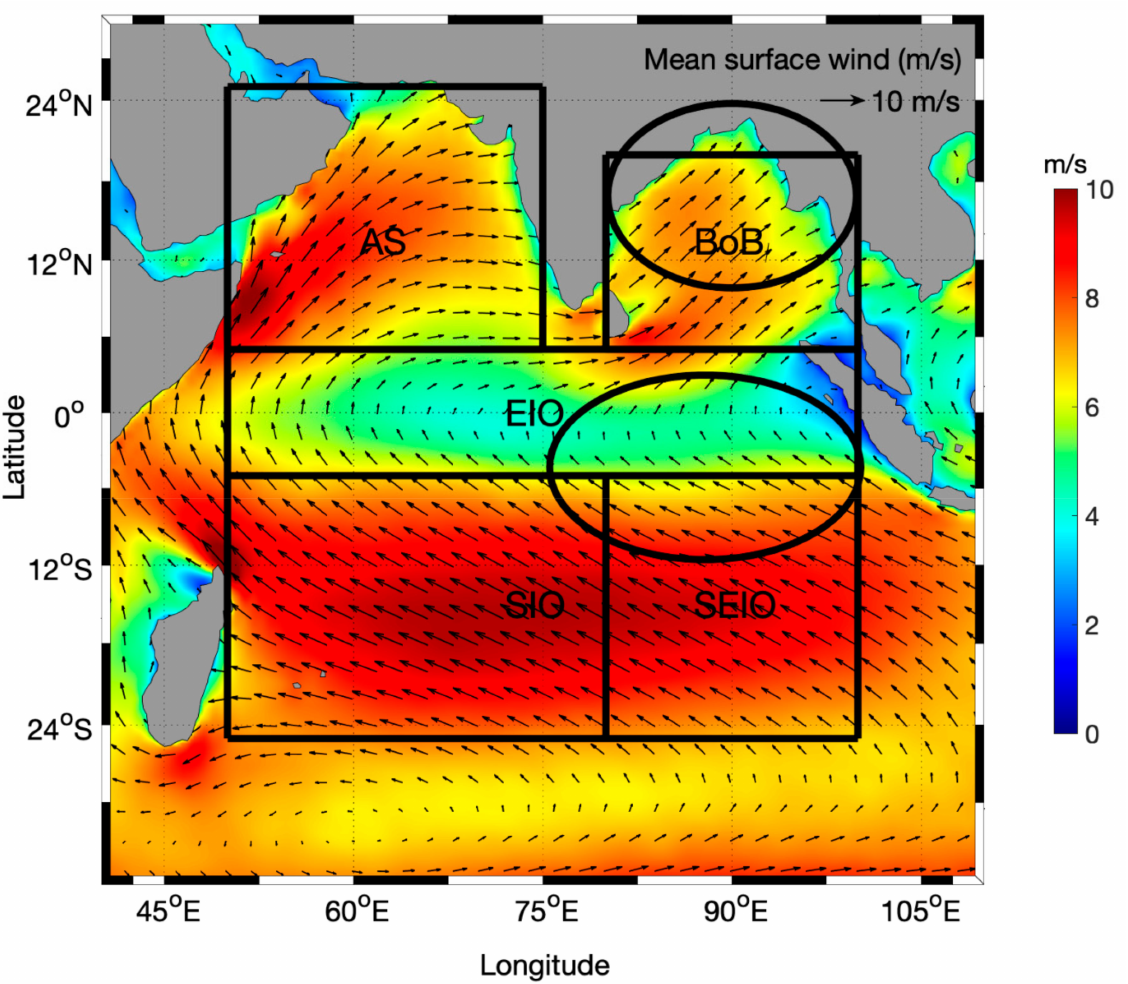
Figure 1. Mean May–October surface wind magnitude over the Indian Ocean (shaded; m/s) overlaid with wind vectors (vectors; m/s). Boxes designate regions used for comparative time series: the Arabian Sea (AS; 50–75 ◦ E, 5–25 ◦ N), Bay of Bengal (BoB; 80–100 ◦ E, 5–20 ◦ N), equatorial Indian Ocean (EIO; 50–100 ◦ E, 5 ◦ S–5 ◦ N), southern Indian Ocean (SIO; 50–100 ◦ E, 5–25 ◦ S), and southeastern Indian Ocean (SEIO; 80–100 ◦ E, 5–25 ◦ S). Black circles indicate the general locations of the northern (top) and southern (bottom) cells in the 10–20-day double-cell